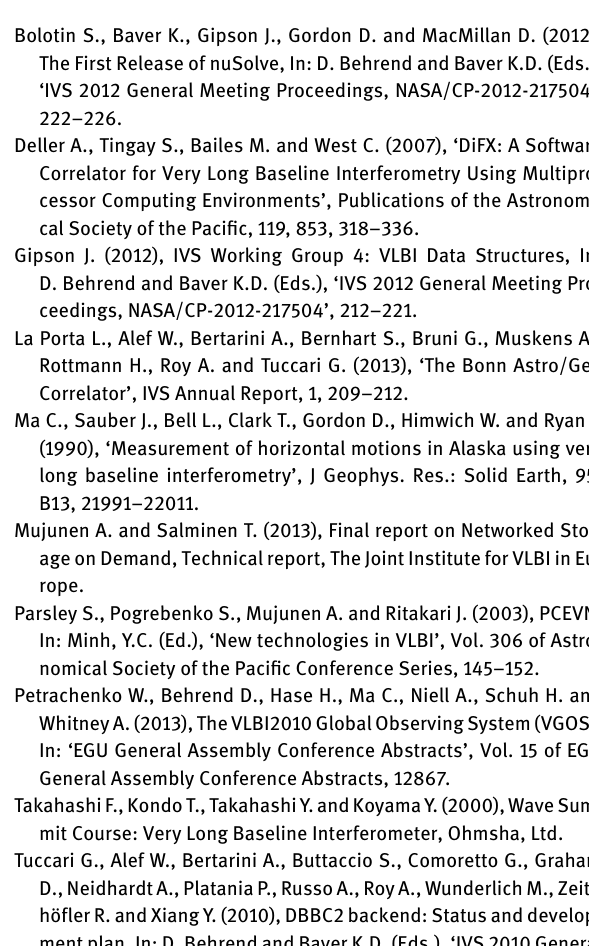
Figure 10: Histogram of the ratio between absolute ZWD differences (On-Od) and their formal errors for IVS-R1 (left) and CONT14 (right) ses- sions.